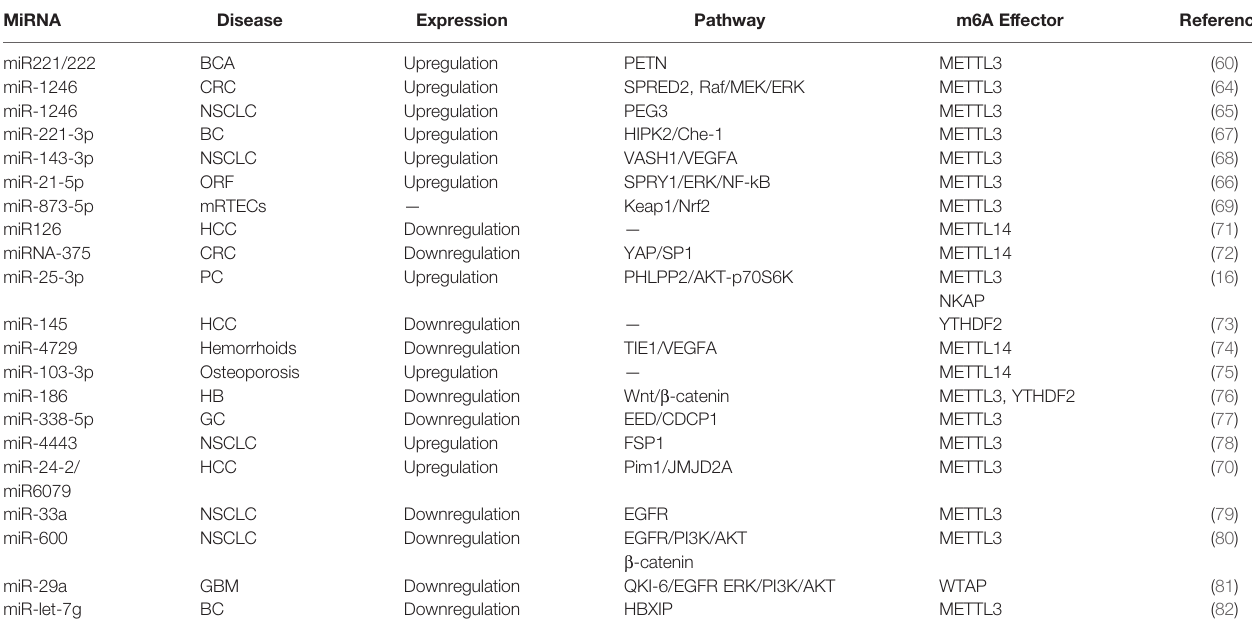
TABLE 2 | MicroRNAs in disease and related m6A effectors. MiRNA